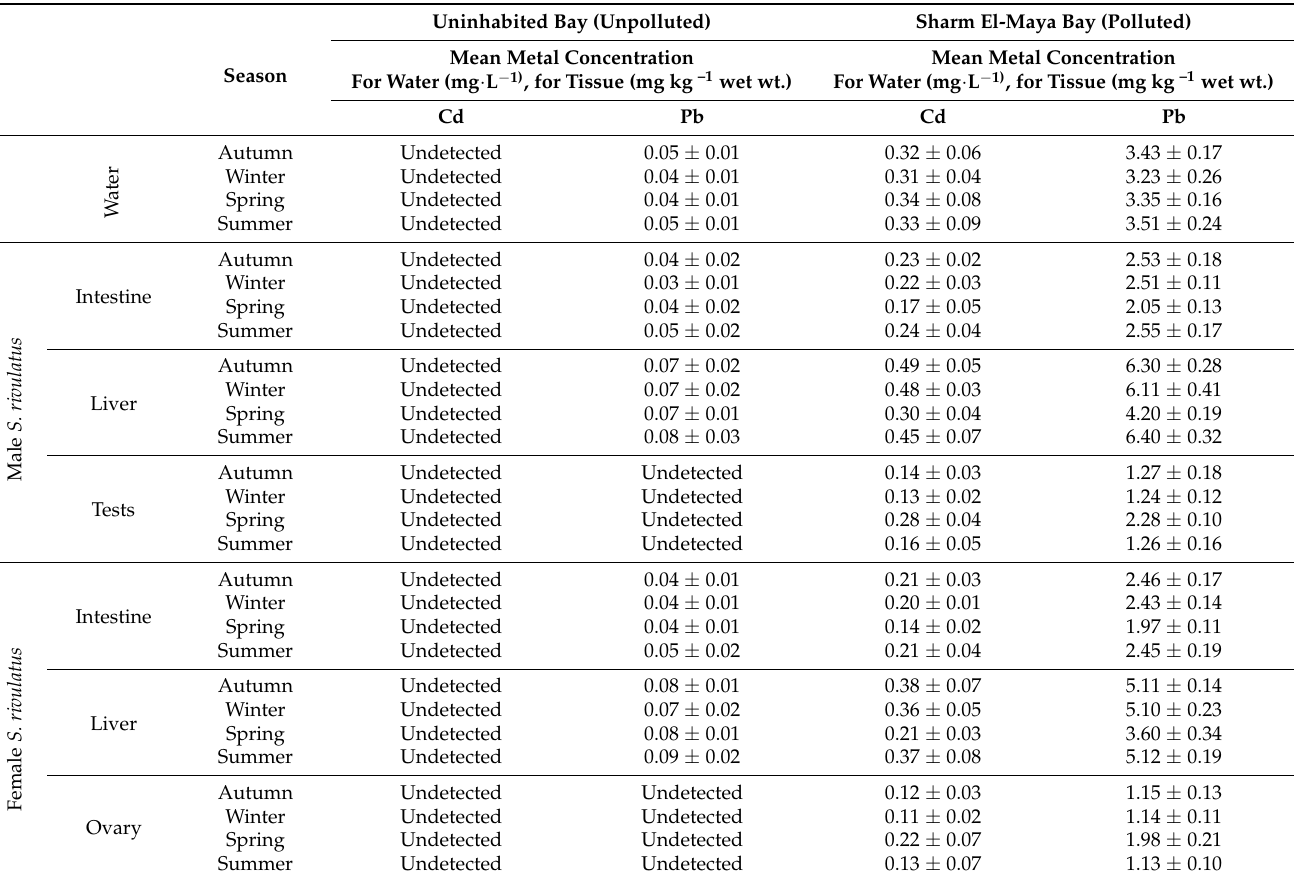
Table 3. Mean seasonal concentrations of Cd and Pb in the water of each bay and in the intestine, liver, and gonads of both sexes of S. rivulatus inhabiting each